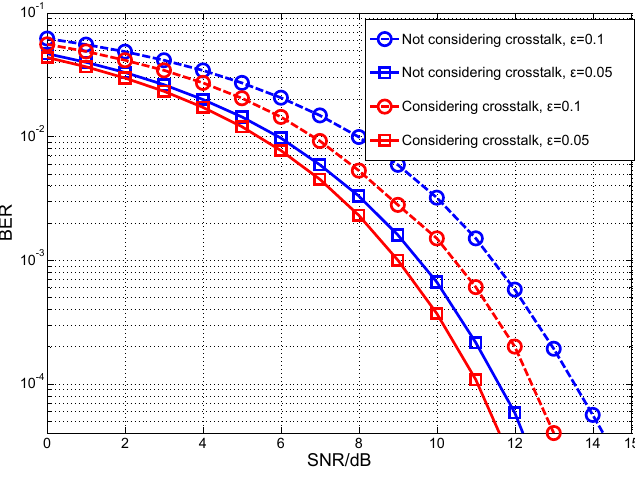
Figure 5. Error performance for the proposed system model and the conventional wavelength-division multiplexing (WDM)-VLC model under different crosstalk coefficients (cid:101) at CCT = 5000